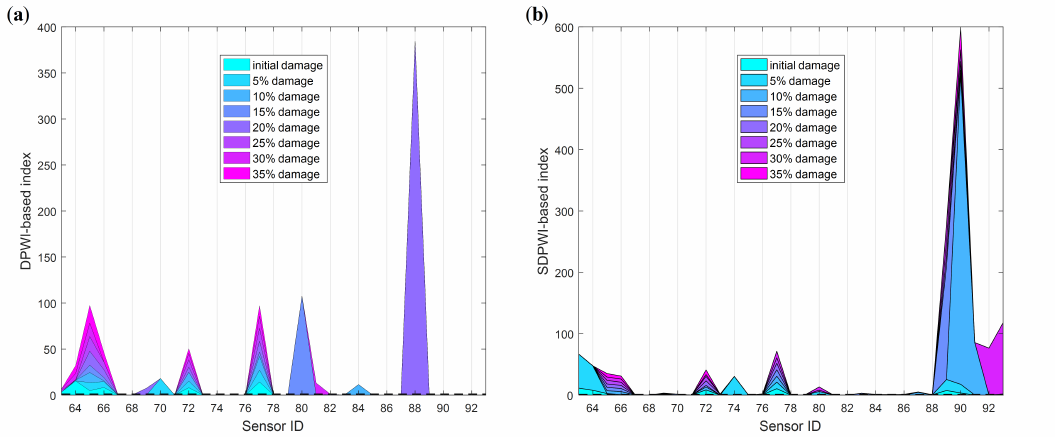
Figure 19. Comparison of noiseless and noisy signals of U x with SNR = 60 dB: ( a ) noiseless data; ( b ) noisy data; ( c ) differences between noiseless and noisy data.